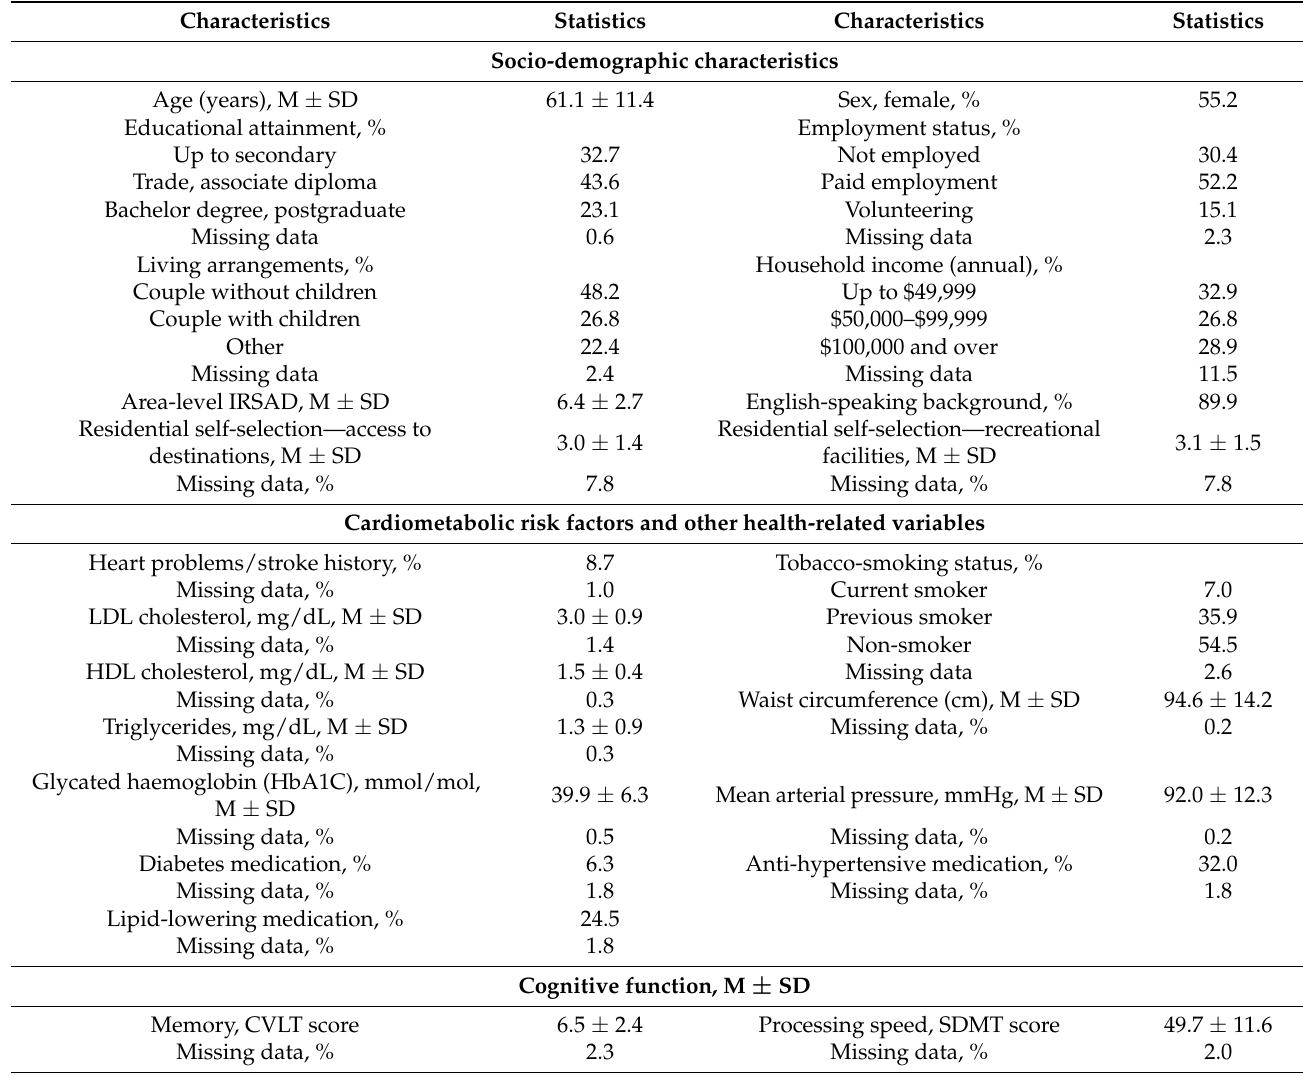
Table 1. Sample characteristics (N =